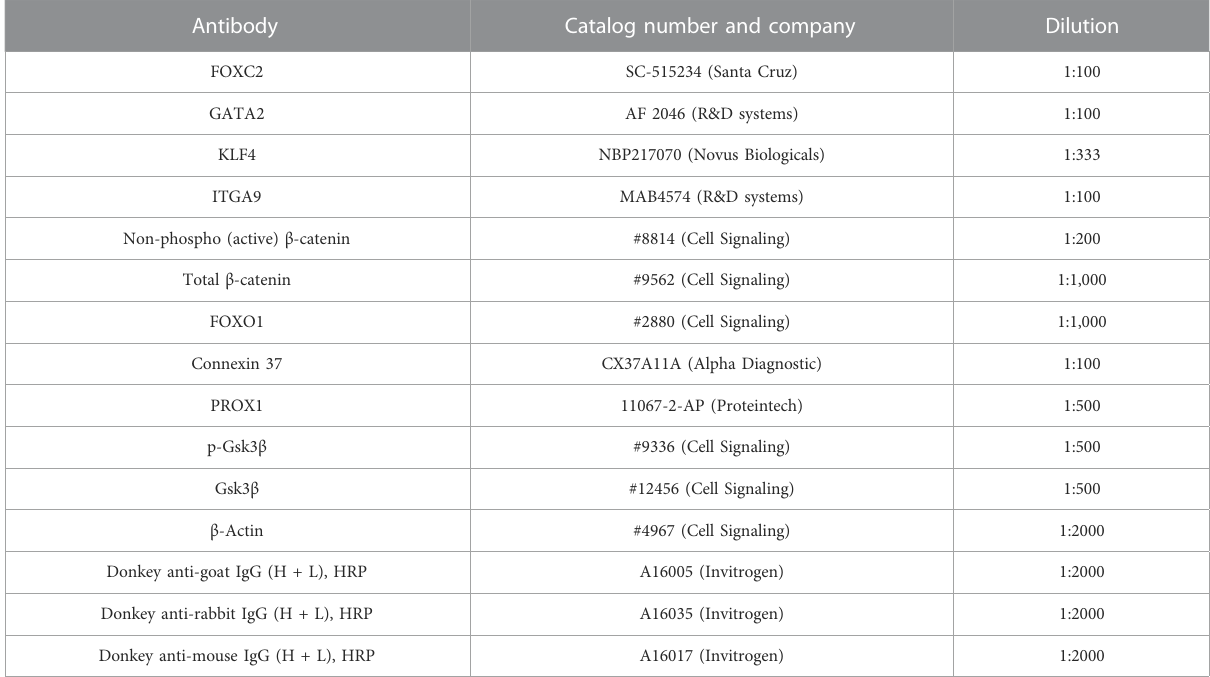
TABLE 2 Western blot antibodies. Antibody Catalog number and